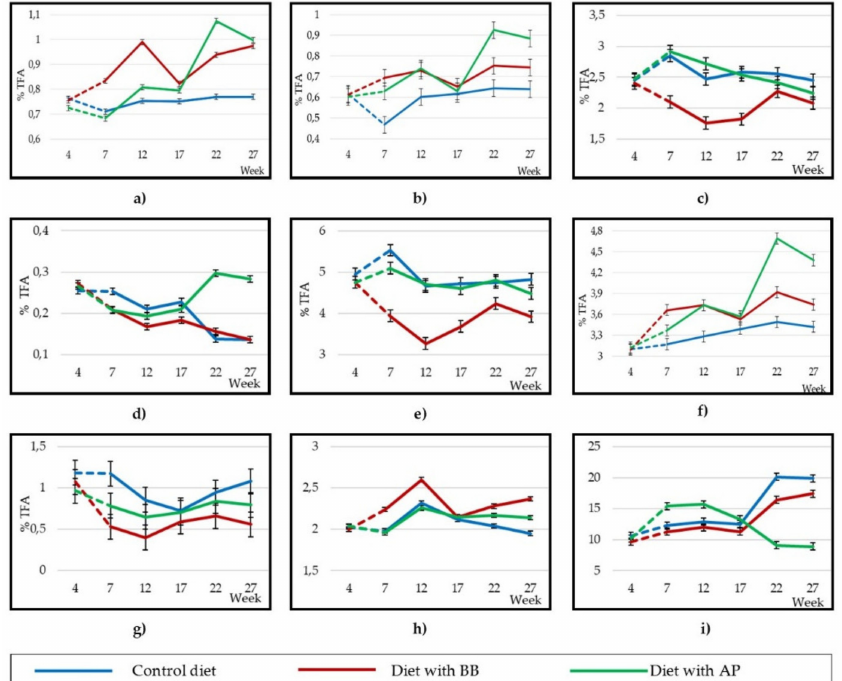
Figure 3. Changes in goat milk lipid profile from refrigerated tank (3 samples / sampling and